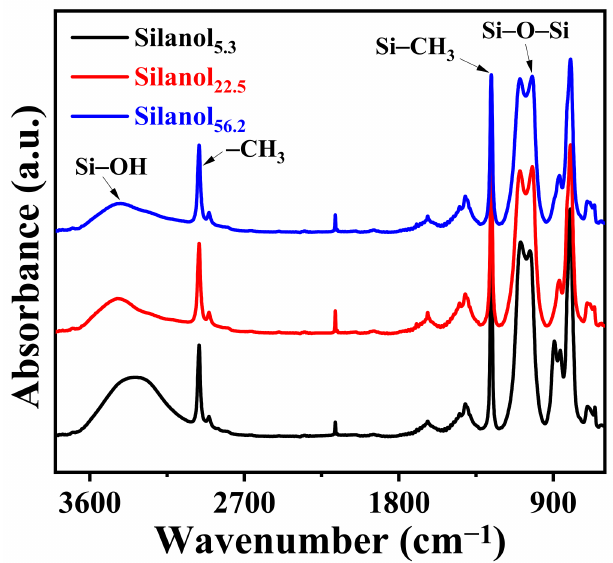
Figure 2. ATR-IR spectra of silanol-terminated PDMS with different block lengths.